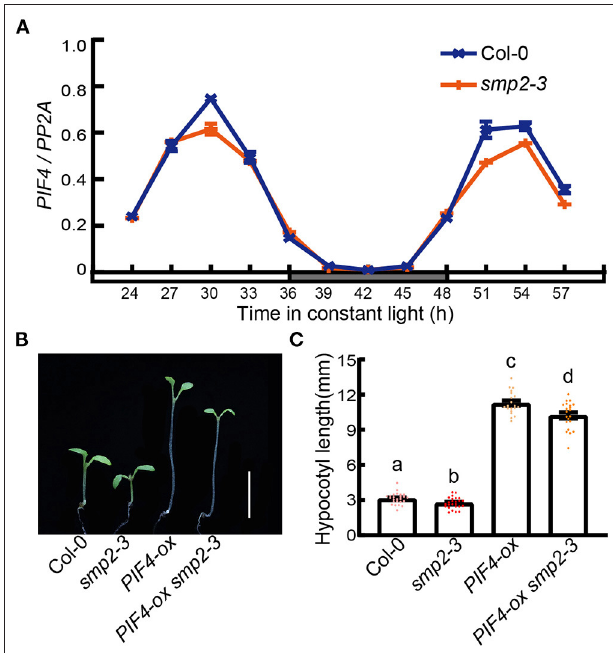
FIGURE 5 | PIF4 contributes to SMP2-mediated hypocotyl elongation. (A) The relative expression of PIF4 in Col-0 and smp2-3 . Seedlings were entrained in the diurnal cycles (12h light/12h dark) for 6 days and then transferred to continuous white light (145 µ mol · m − 2 · s − 1 ). Seedlings were harvested at the indicated times. The relative expression levels of PIF4 were normalized to PP2A . Error bars represent SD, n = 3. (B) Visual phenotypes of 5-day-old Col-0, smp2-3 , PIF4-ox and PIF4-ox smp2-3 seedlings grown in continuous red light condition (145 µ mol · m − 2 · s − 1 ). Scale bars, 5mm. (C) Quantification of hypocotyl length of Col-0, smp2-3 , PIF4-ox and PIF4-ox smp2-3 seedlings grown in continuous red light. Error bars represent SD, n ≥ 20. Letters above the bars indicate significant differences ( P < 0.05), as determined by one-way analysis of variance (ANOVA) with Duncan’s post-hoc